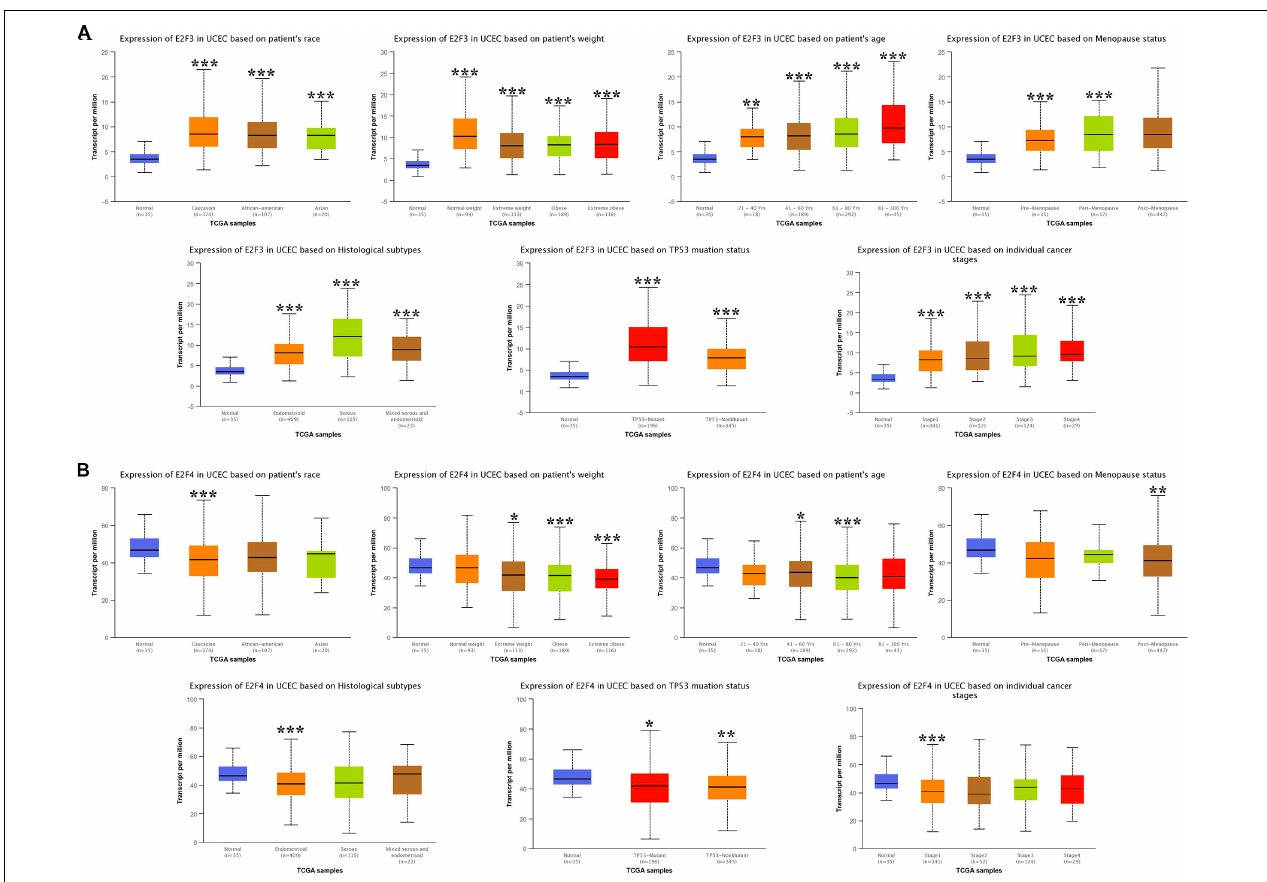
FIGURE 5 | The expression level of E2F3 and E2F4 in UCEC. (A) E2F3 expression in multiple subgroups of patients with UCEC. Stratified along race, weight, age, menopause status, histological subtypes, TP53 mutation status, and cancer stage. (B) E2F4 expression in subgroups of patients with UCEC, stratified along race, weight, age, menopause status, histological subtypes, TP53 mutation status, and cancer stage. * P < 0.05; ** P < 0.01; *** P <